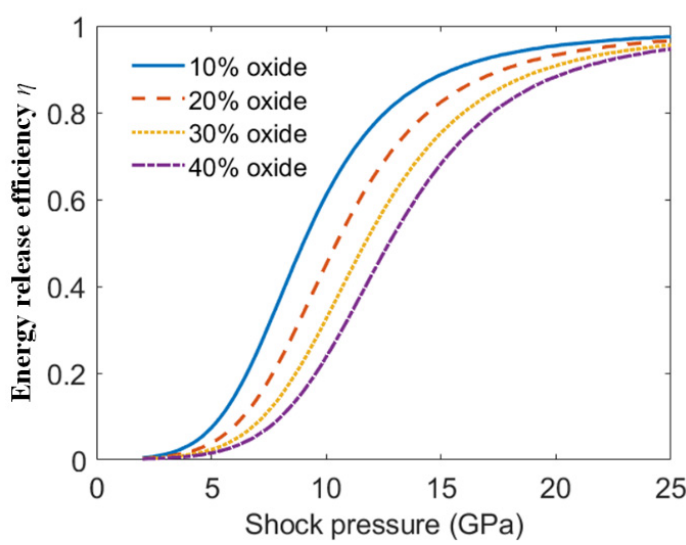
Figure 8. Energy release efficiency varying with shock pressure.